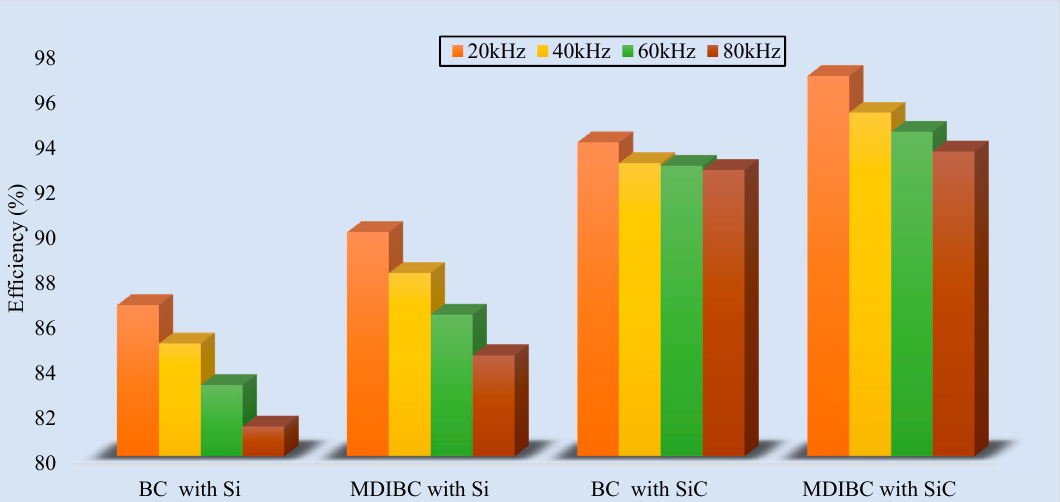
Figure 24. Comparative e ffi ciency measurement of BC and MDIBC using Si and SiC